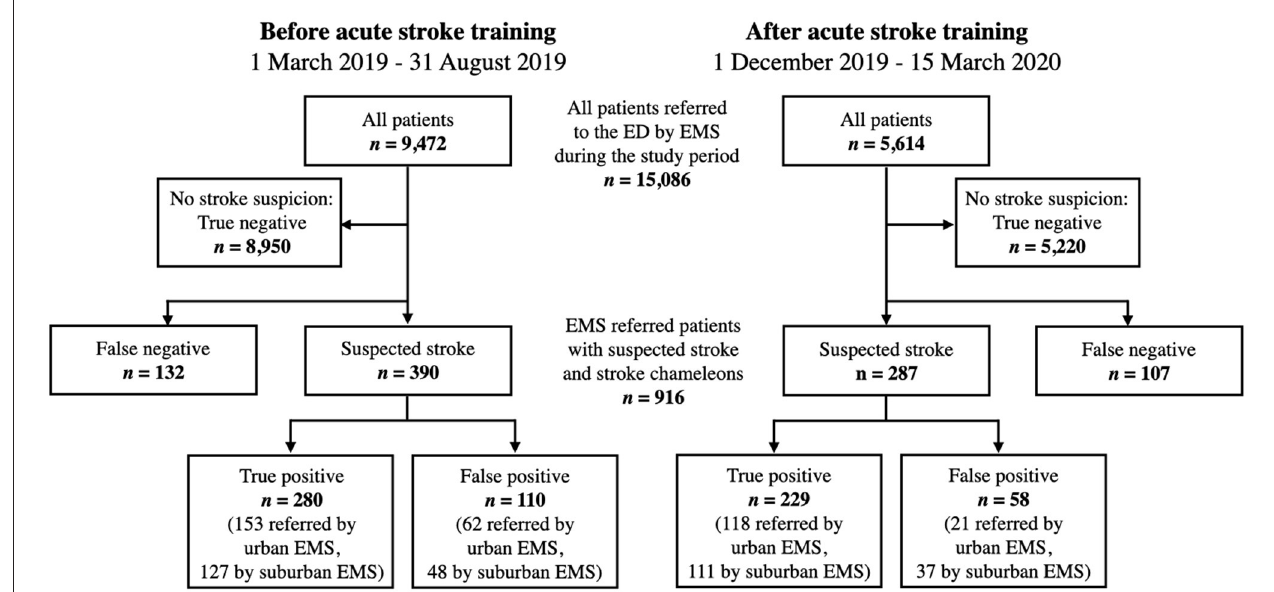
FIGURE 1 | Flowchart of the study population. Patients were referred to the emergency department (ED) of Vilnius University Hospital by emergency medical services (EMS) between March 1, 2019 and March 15, 2020.